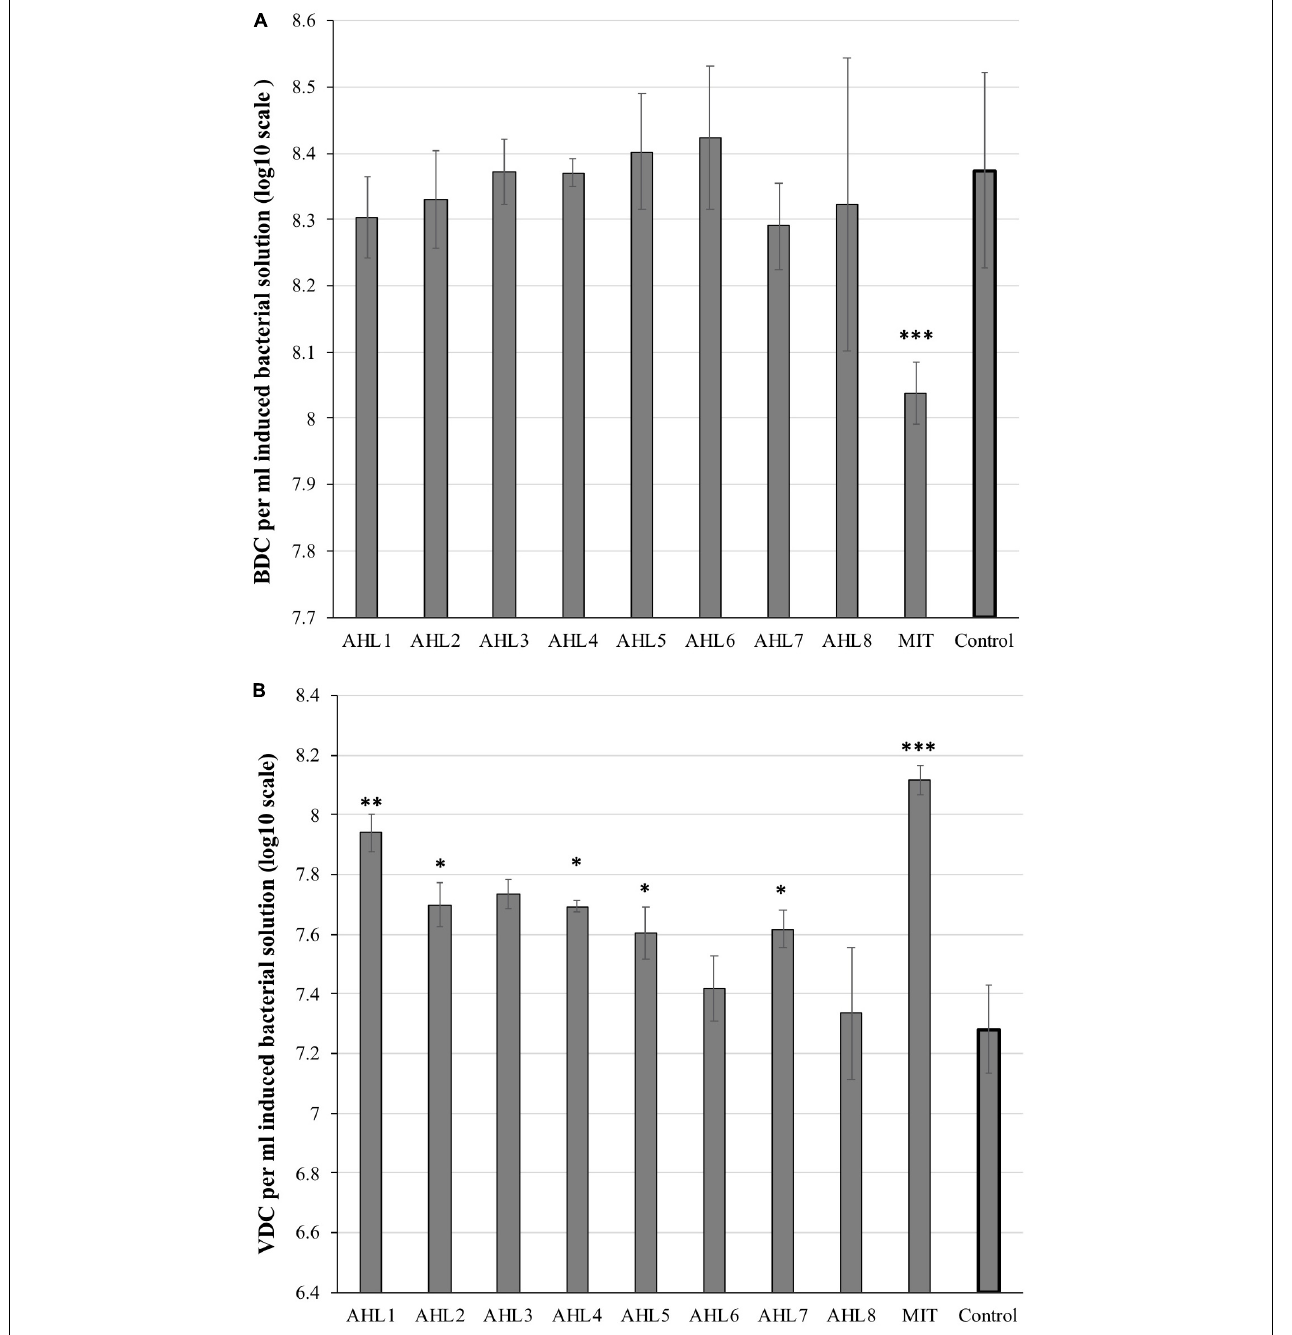
FIGURE 1 | Microscopic direct counts of bacteria (A) and viruses (B) in the induced and control cell suspensions after prophage induction. Inducing agents included mitomycin C (MIT) and N-(Butyryl, Hexanoyl, β -Ketocaproyl, Heptanoyl, Octanoyl, 3-Oxododecanoyl, Tetradecanoyl, and 3-Oxotetradecanoyl) homoserine lactones (represented as AHL1–8). Control indicates unamended control cell suspensions without AHLs or Mitomycin C treatment. Each bar represents the mean of triplicate assays ( n = 3), and the error bars show one standard deviation. Statistical significance between the treatment and the control group is indicated by ∗ p < 0.05, ∗∗ p < 0.01, and ∗∗∗ p < 0.001.